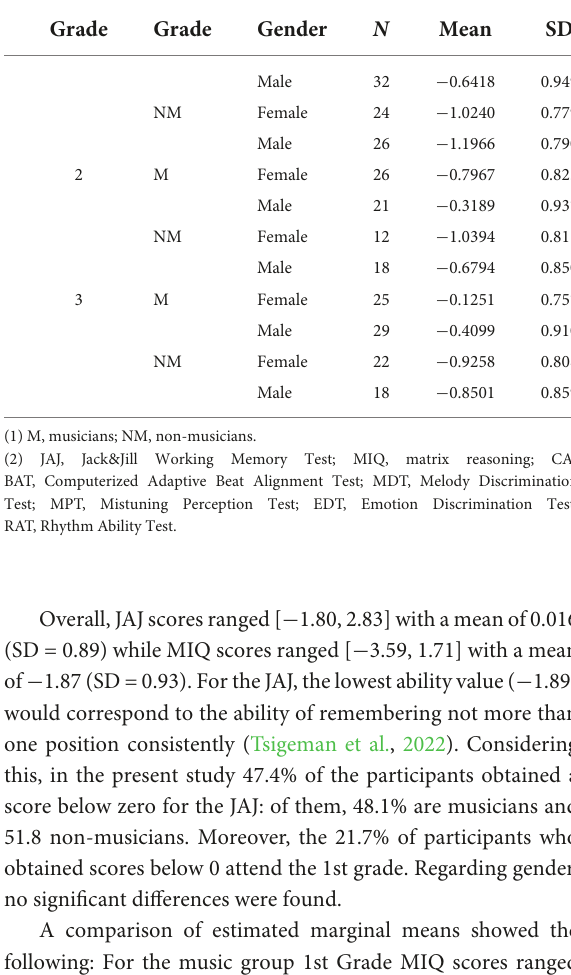
TABLE 4 Descriptive statistics for all the perceptive